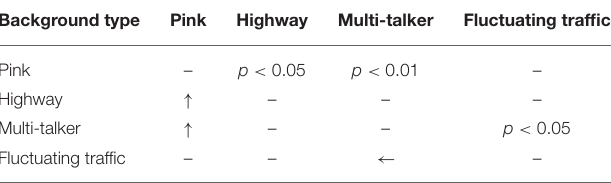
TABLE 3 | Effect of background noise on exam z-score; Tukey post-hoc multiple comparisons between different types of background noise for modeling exam z-score in lecture attended task (using mixed-effect